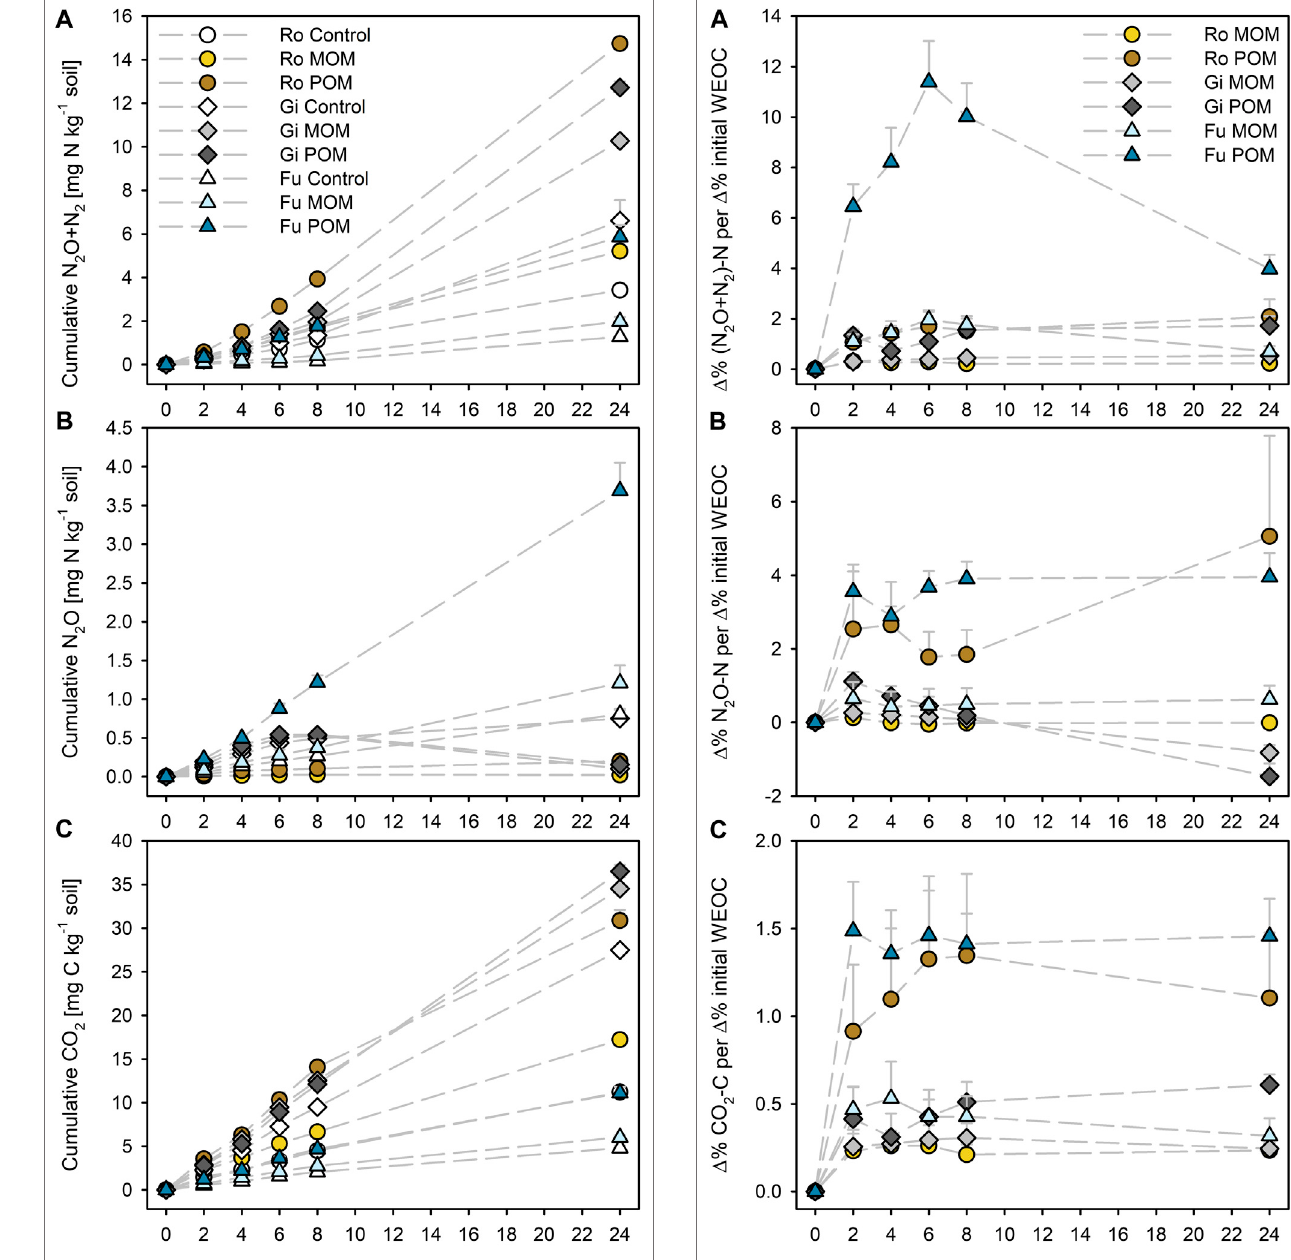
was smaller than to the production of nitrogenous gases in all three soils. The relative contribution of OM fractions differed only slightly with incubation time, but percentage differences